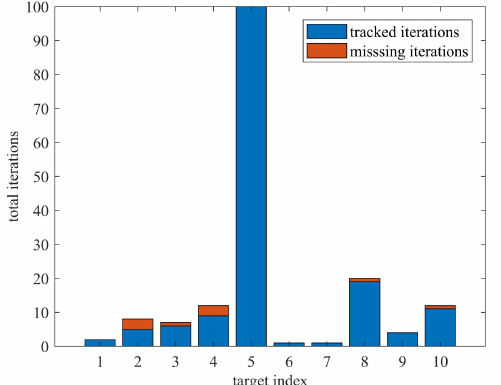
Figure 19. The overall tracked iterations and missing iterations of ten tracks in all 100 iterations. The blue denotes the tracked iterations and orange denotes the missing iterations. The 5th track is real moving target, which shows it is tracked in 100 iterations without missing. The rest tracks correspond to the false detections stop updating after 20